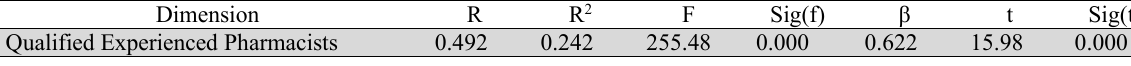
Simple linear regression for testing the impact of qualified and experienced pharmacists on pharmacies selection